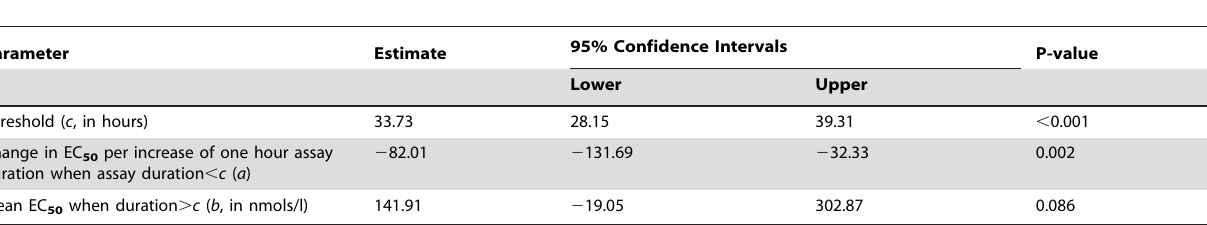
Table 1. Parameter estimates for threshold modelling of the relationship between assay duration and CQ EC 50 in P. vivax .